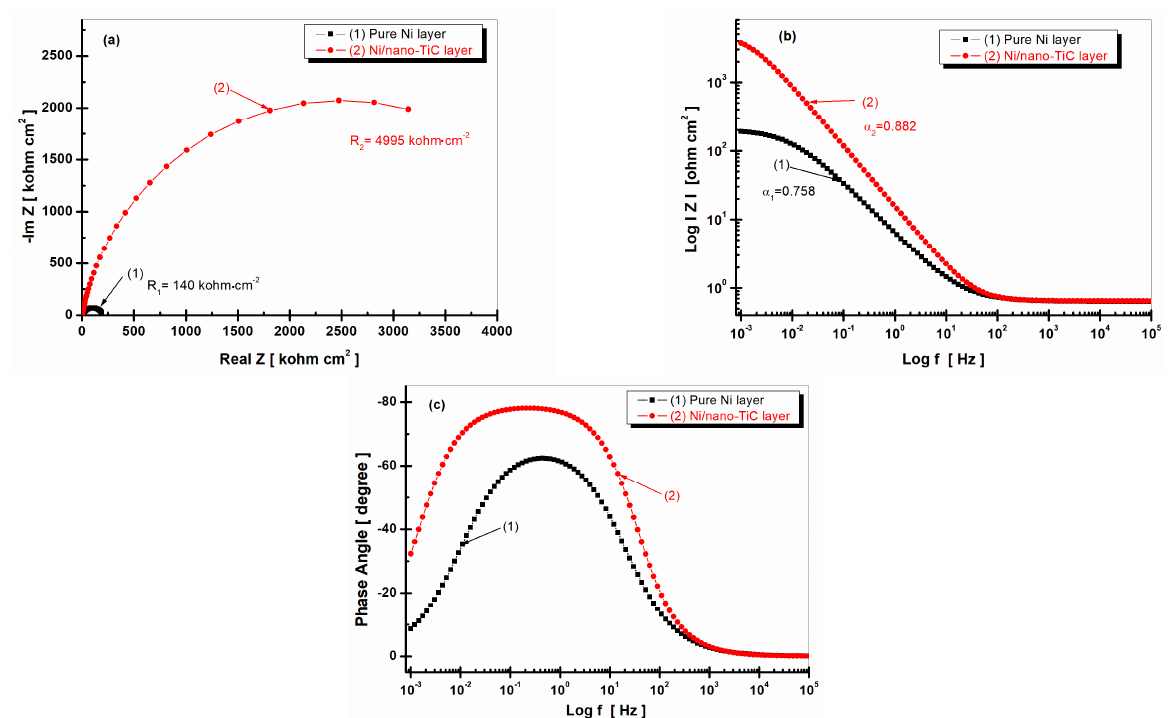
Figure 8. Electrochemical impedance spectroscopy results shown as symbols and fitted lines after 48 h of immersion for (1) the pure Ni layer; (2) the Ni/nano-TiC layer. ( a ) Nyquist representation; ( b ) module Z versus logarithm of frequency; ( c ) phase angle versus logarithm of frequency.